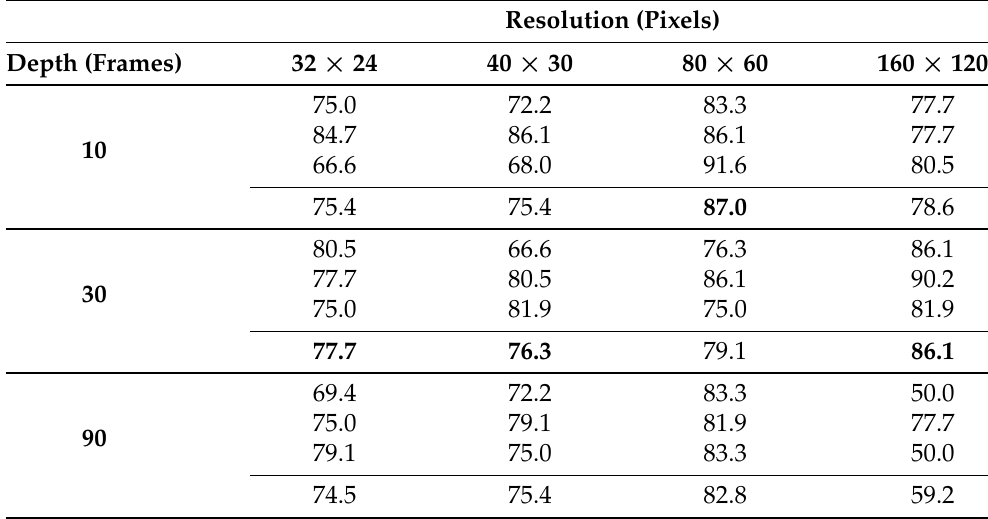
Table 7. Accuracy (%) of the models trained with the 12 different configurations from experiment C01 (balanced dataset with data augmentation). Each cell presents the accuracy of the three independent models per configuration and its average. The best results per resolution are highlighted in bold.